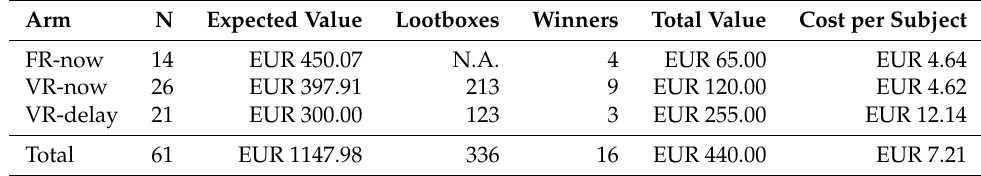
Table 2. Total costs of reinforcement